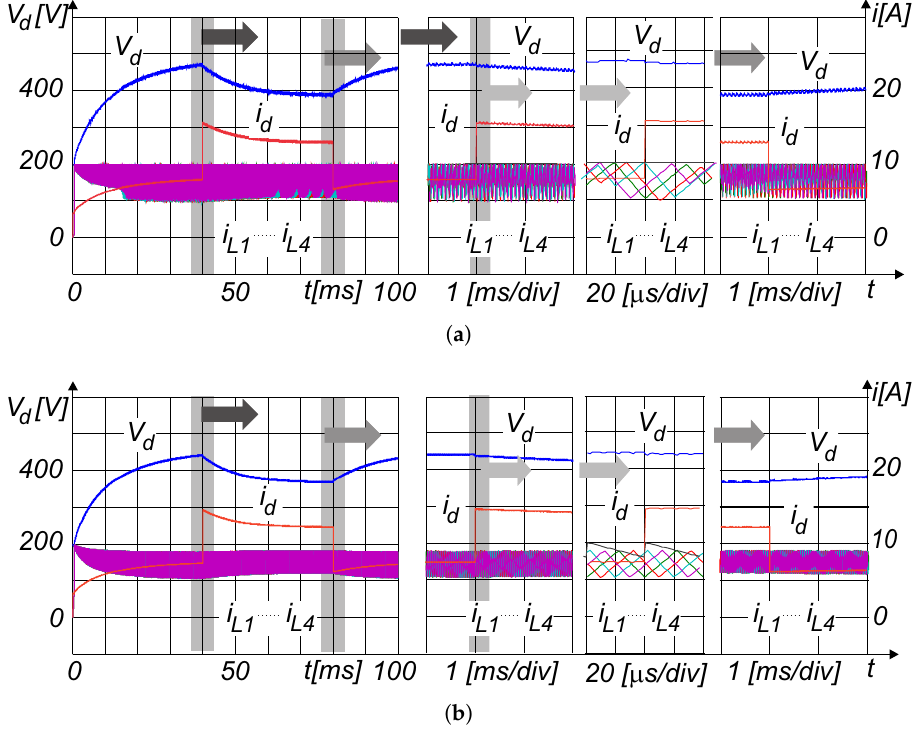
Figure 12. Simulation results, current-programmed mode control, boost mode: ( a ) without CR; ( b ) with CR; V d (blue curve), i d (red curve), i L 1 (green curve), i L 2 (violet curve), i L 3 (cyan curve), and i L 4 (dark red